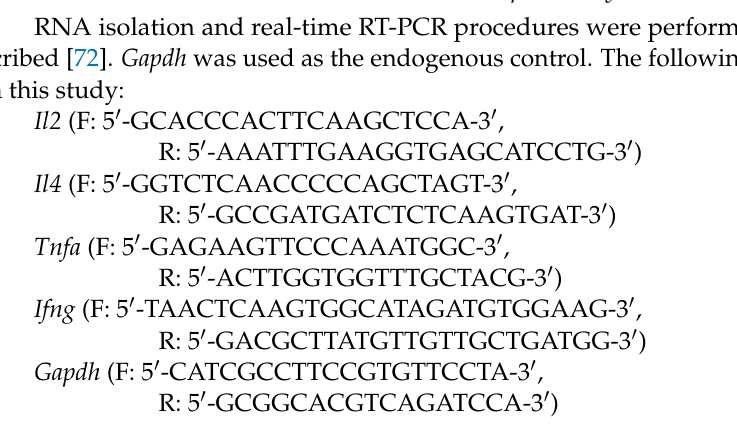
sulfate of SH.; Figure S1: SH enhances immune functions in BALB/c mice.; Figure S2: SH increases T cell and neutrophil count in